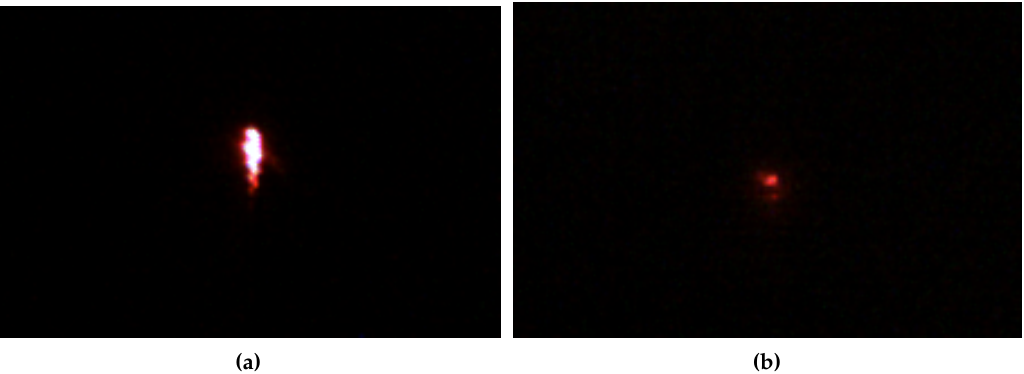
Figure 12. Visible images of the reflected laser. ( a ) Clean reflector, ( b ) Reflector polluted with 0.1g fine